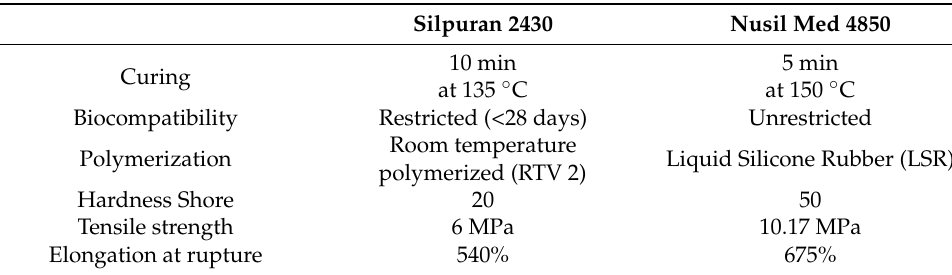
Table 1. Material properties of Silpuran 2430 and Nusil Med 4850